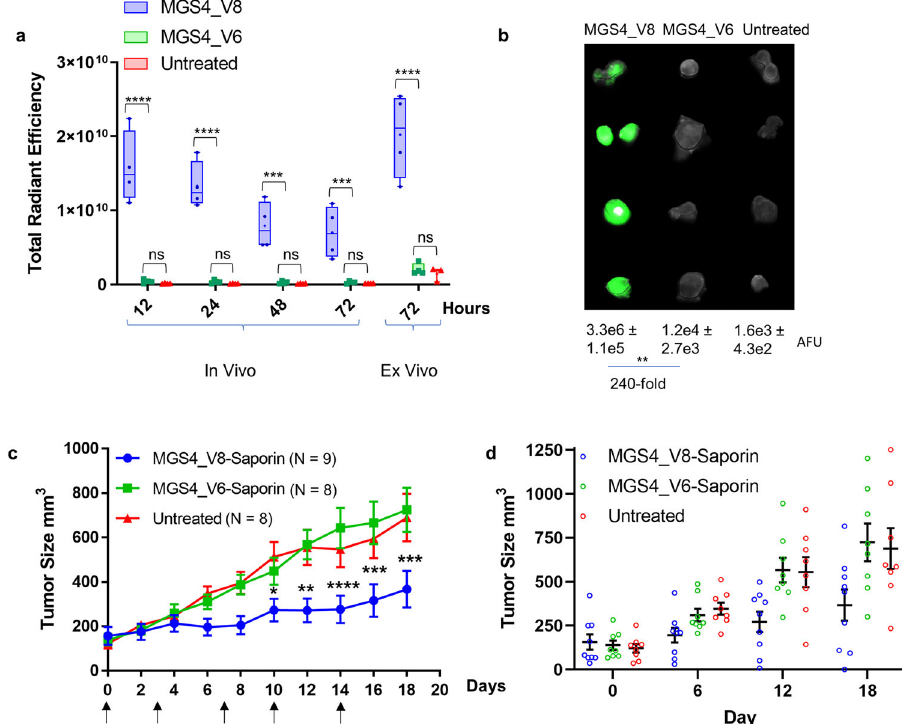
Fig. 5 MGS4_V8 homes to xenograft tumor after systemic delivery and can deliver saporin resulting in reduced tumor growth. a H2009 tumor bearing nude mice ( N = 4) were injected I.V. with MGS4_V8 or MGS4_V6 conjugated to NIR dye Alexa Fluor 750. At 12, 24, 48, and 72h postinjection, mice